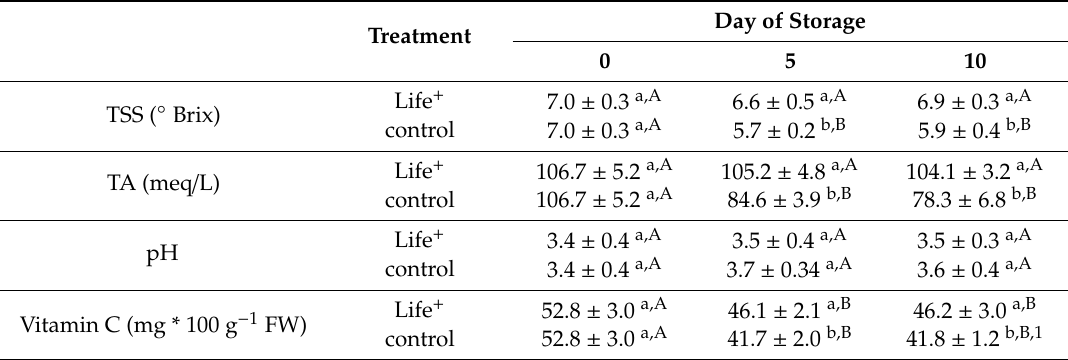
Table 6. Evolution of quality parameters for strawberries (Total Soluble Solids (TSS), Titratable Acidity (TA), and Vitamin C content) during cold storage at 6 ◦ C for 0 to 10